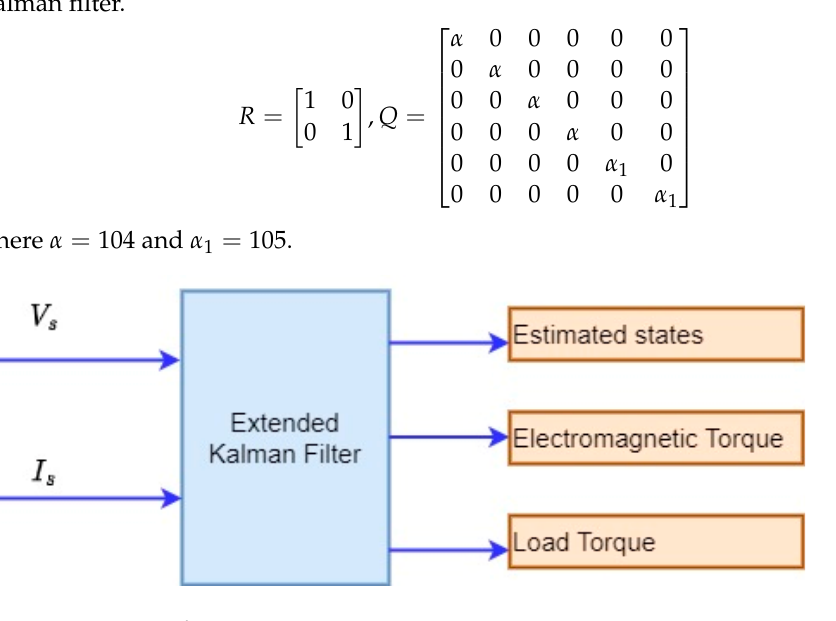
Figure 4. Structure of EKF.